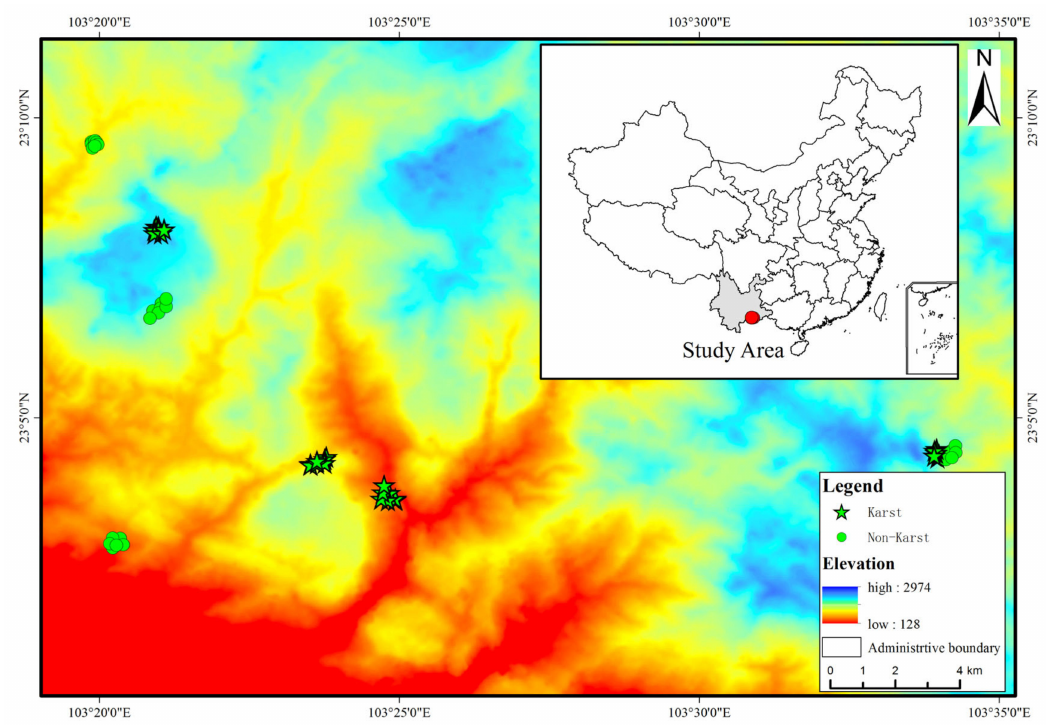
Figure 1. Locations of plots in Dawei Mountain area in Yunnan Province, Southwestern